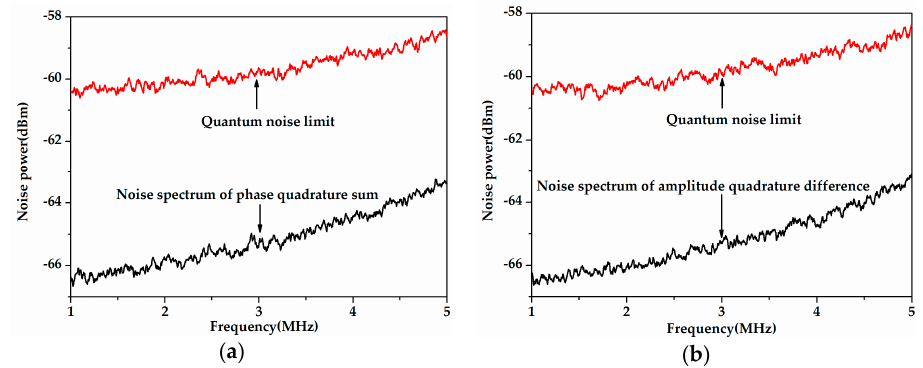
Figure 5. Measured broadband noise spectrum between the two-color down-converted optical fields from 1 MHz to 5 MHz. ( a ) phase quadrature sum; ( b ) amplitude quadrature difference. The RBW and VBW of the SA were 300 kHz and 100 Hz, respectively.